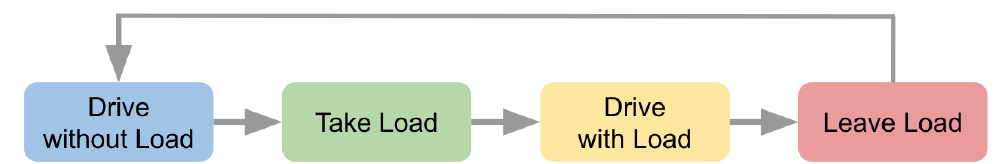
Figure 4. The logical order of forklift activities. Some papers [5,19] refer to this as “working cycles” of